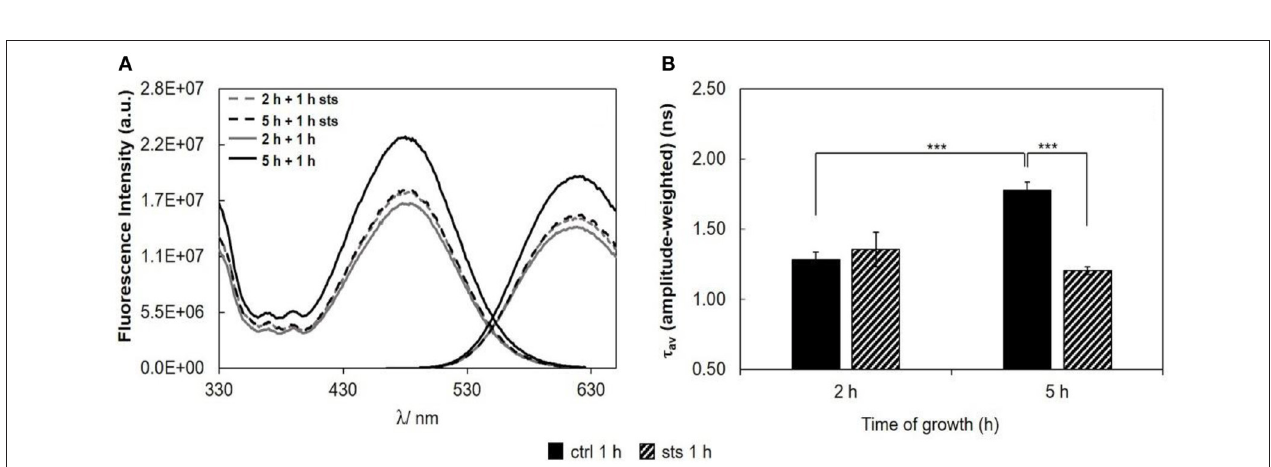
FIGURE 6 | Di-4-ANEPPS fluorescence properties in N. crassa cells, at 30 ◦ C, (A) fluorescence excitation ( λ em = 635nm) and emission spectra ( λ exc = 450nm), (B) amplitude-weighted mean fluorescence lifetime of di-4-ANEPPS. The results present the mean ± S.D. of at least three independent experiments, n ≥ 3. *** p < 0.001.